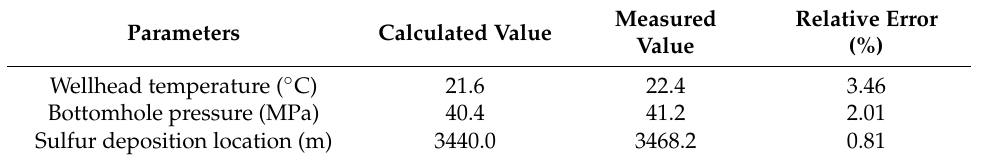
Table 2. Calculation results of model validation.